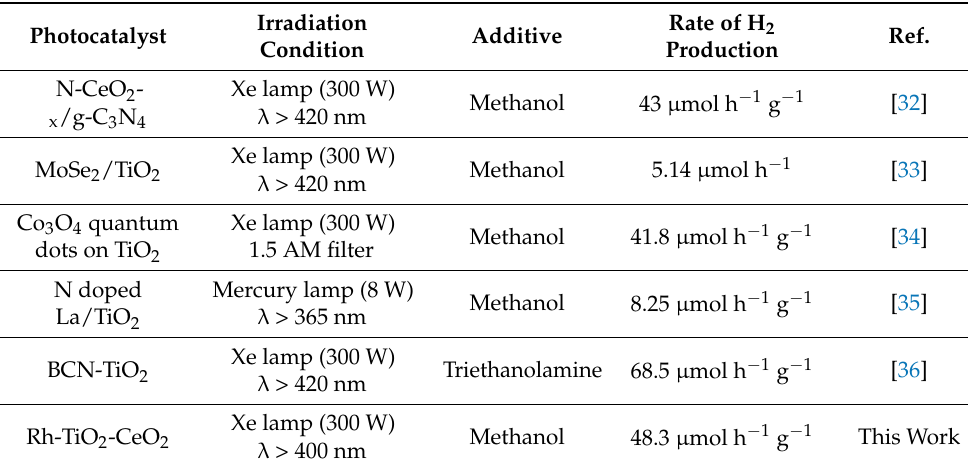
Figure 7. ( a ) Amount of evolved hydrogen during photocatalysis with different photocatalysts under visible light irradiation ( λ > 400 nm) and ( b ) the corresponding hydrogen production rates. ( c ) Recyclability of the Rh–TiO 2 –CeO 2 hybrid photocatalysts for photocatalytic hydrogen production. Each photocatalysis cycle was conducted for 4 h. ( d ) Photocurrents, ( e ) PL, and ( f ) HER of different photocatalysts. Table 1. Comparative results for photocatalytic H 2 evolution based on previous reports using TiO 2 or CeO 2 -based photocatalysts in the literature.